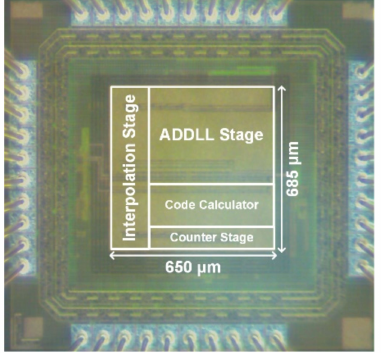
Figure 9. Microphotograph of timing monitor chip.